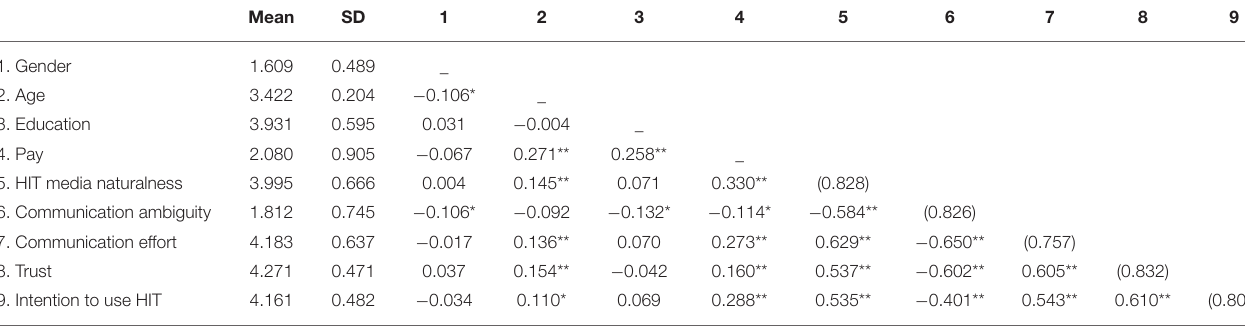
TABLE 2 | Means, standard deviations, correlations, and reliabilities of studied variables.